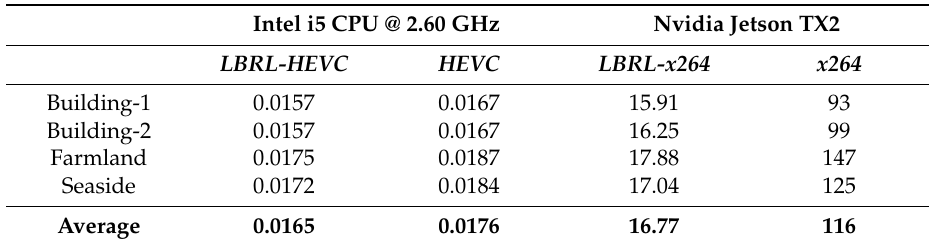
Table 5. Computational speed of LBRL-HEVC , HEVC , LBRL-x264 , and x264 , with satellite video data